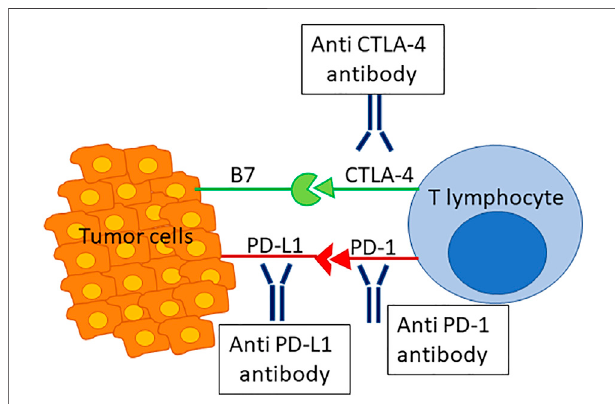
FIGURE 1 | Schematic representation of immunotherapy. CTLA-4 and PD-1 or its ligand (PD-L1) pathways have major roles in regulating autoimmunity and are both targeted by current